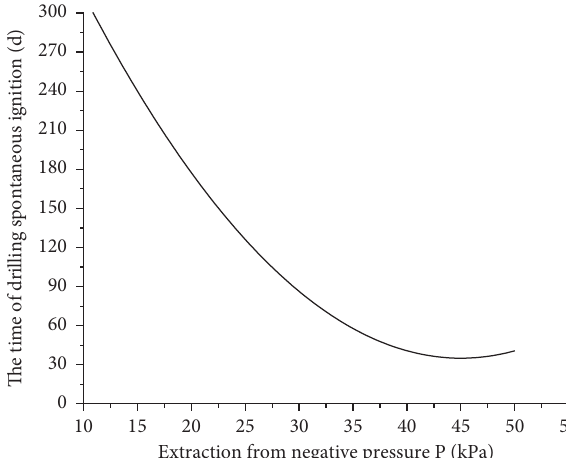
Figure 6: Influence of pumping negative pressure on the natural ignition time of borehole.